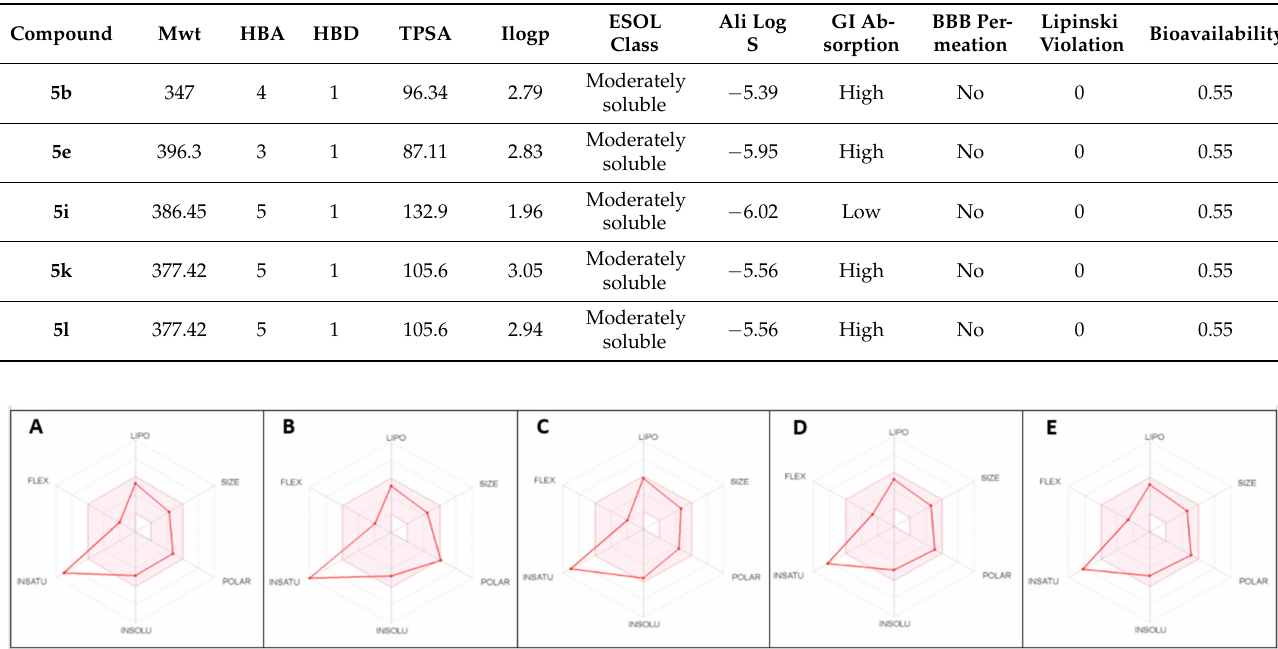
Figure 4. ( A ) Bioavailability radar of 5b . ( B ) Bioavailability radar of 5e . ( C ) Bioavailability radar of 5i . ( D ) Bioavailability radar of 5k . ( E ) Bioavailability radar of 5l . The pink area indicates preferred properties